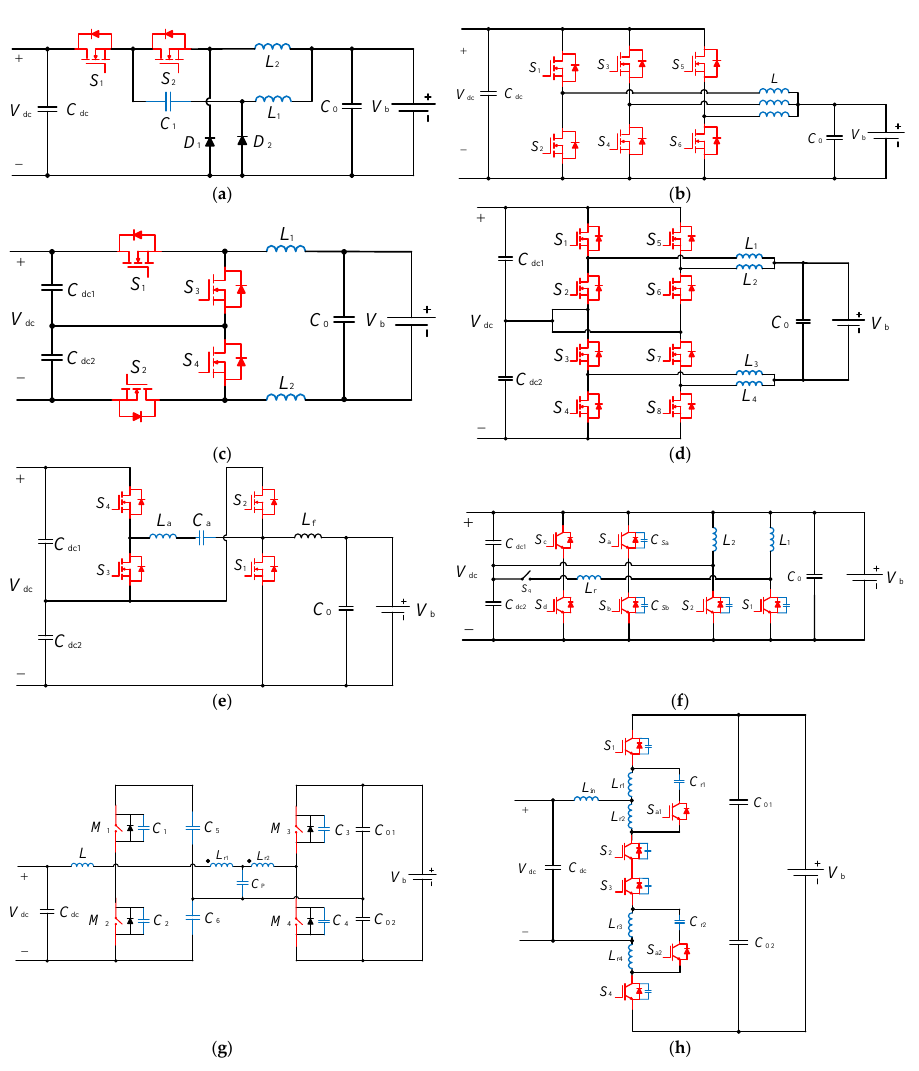
Figure 8. Non-isolated DC–DC converters as the EV-interfaced converter: ( a ) 2-phase interleaved Buck converter (IBC), ( b ) 3-phase IBC, ( c ) 3-level asymmetrical voltage source converter, ( d ) parallel 3-level buck converter, ( e ) zero voltage transition (ZVT) converter, ( f ) interleaved ZVT, ( g ) half-bridge ZVT, and ( h ) 3-level ZVT.